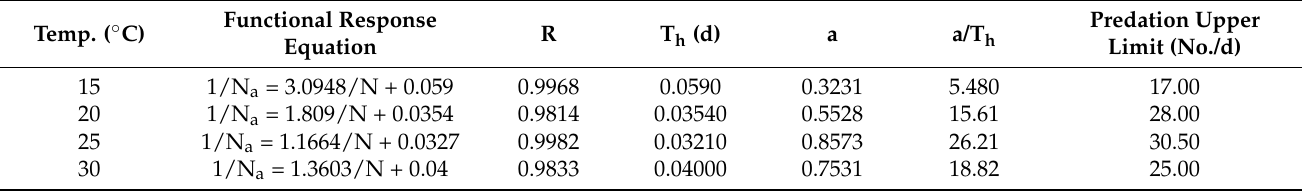
Table 2. Predatory functional responses O. sauteri adults preying on adult tea thrips at different temperatures. Temp. ( ◦ C)